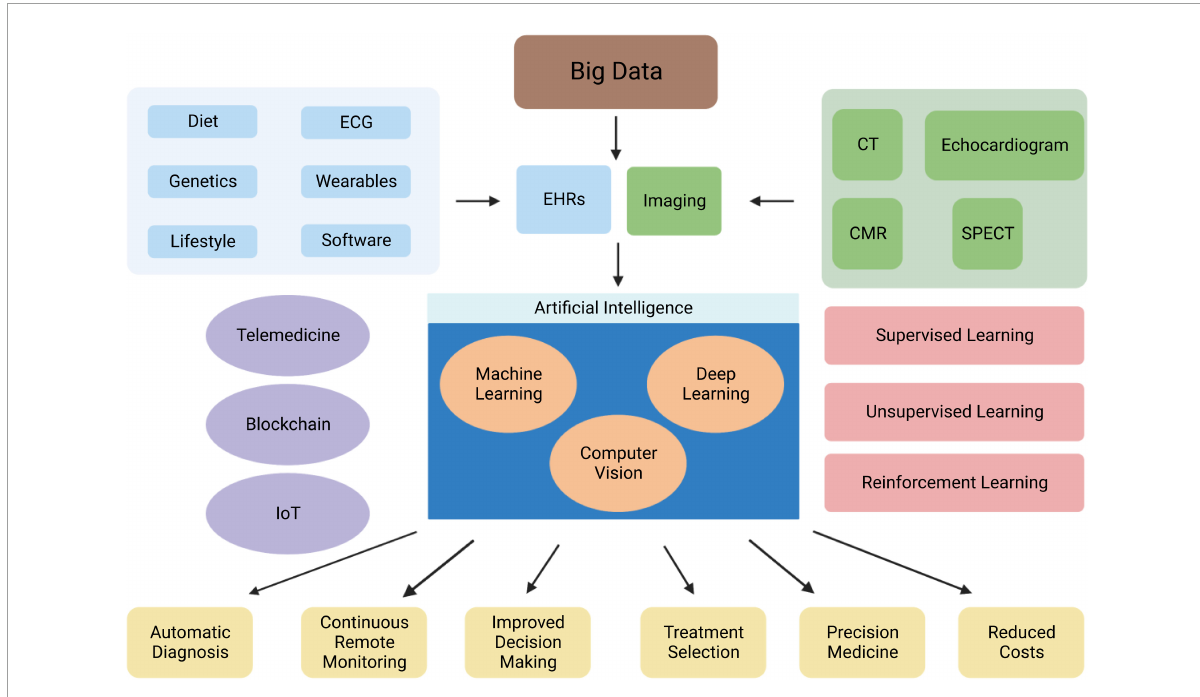
FIGURE2 Overview of the role of AI in cardiovascular medicine. Abbreviations: EHRs, electronic health records; CMR, cardiac magnetic resonance; CT, computed tomography; IoT, internet of things; SPECT, single photon-emission computerised